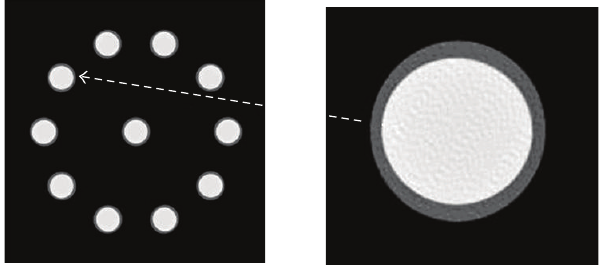
Figure 7: CT image artifacts caused by the offset of an isocenter and the deflection of linear